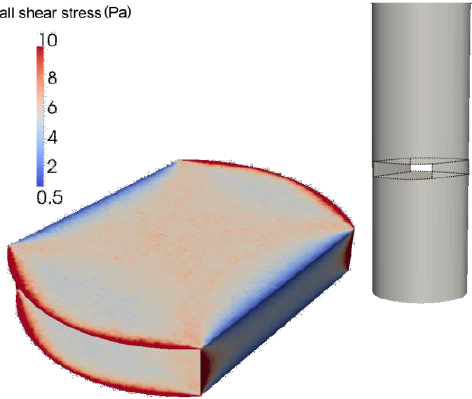
Figure 6. Mean wall shear stress distribution inside the probe slit for an inlet velocity of 𝑢 inlet = 0.03 m/s and a drop size of 150